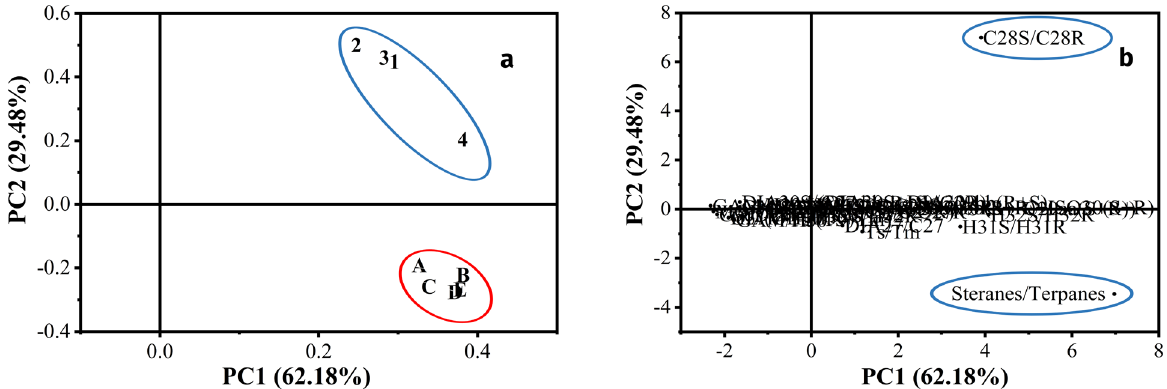
Figure 4 . Principal component analysis score and loading plots. (a) Scores plot of PC1 vs. PC2, generated from the diagnostic ratios data for the oil biomarkers identified in the samples. (b) Loadings plot of PC1 vs. PC2, showing the ratios with the greatest influence on dissimilarity